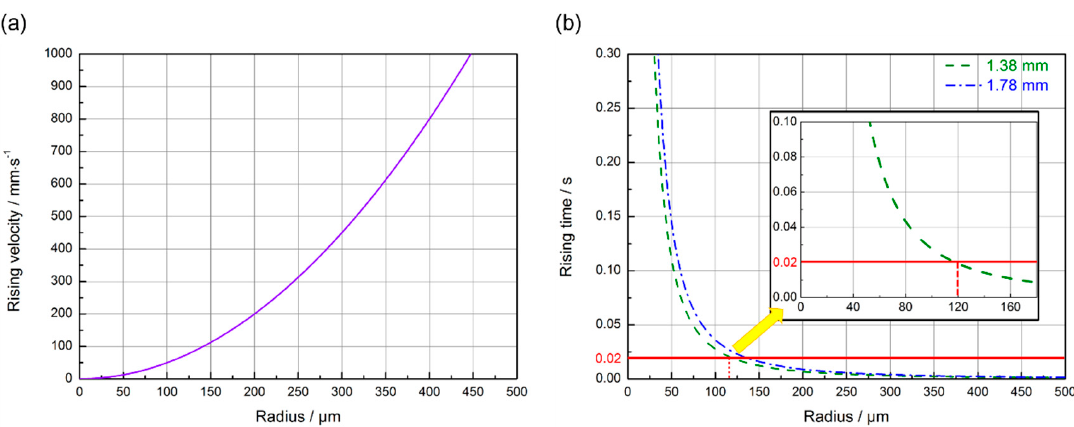
Figure 10. ( a ) The calculated rising velocity of bubbles with different sizes in the NS-Mo alloy molten pool during laser welding; ( b ) escaping time of bubbles with typical size in different molten pool depths.